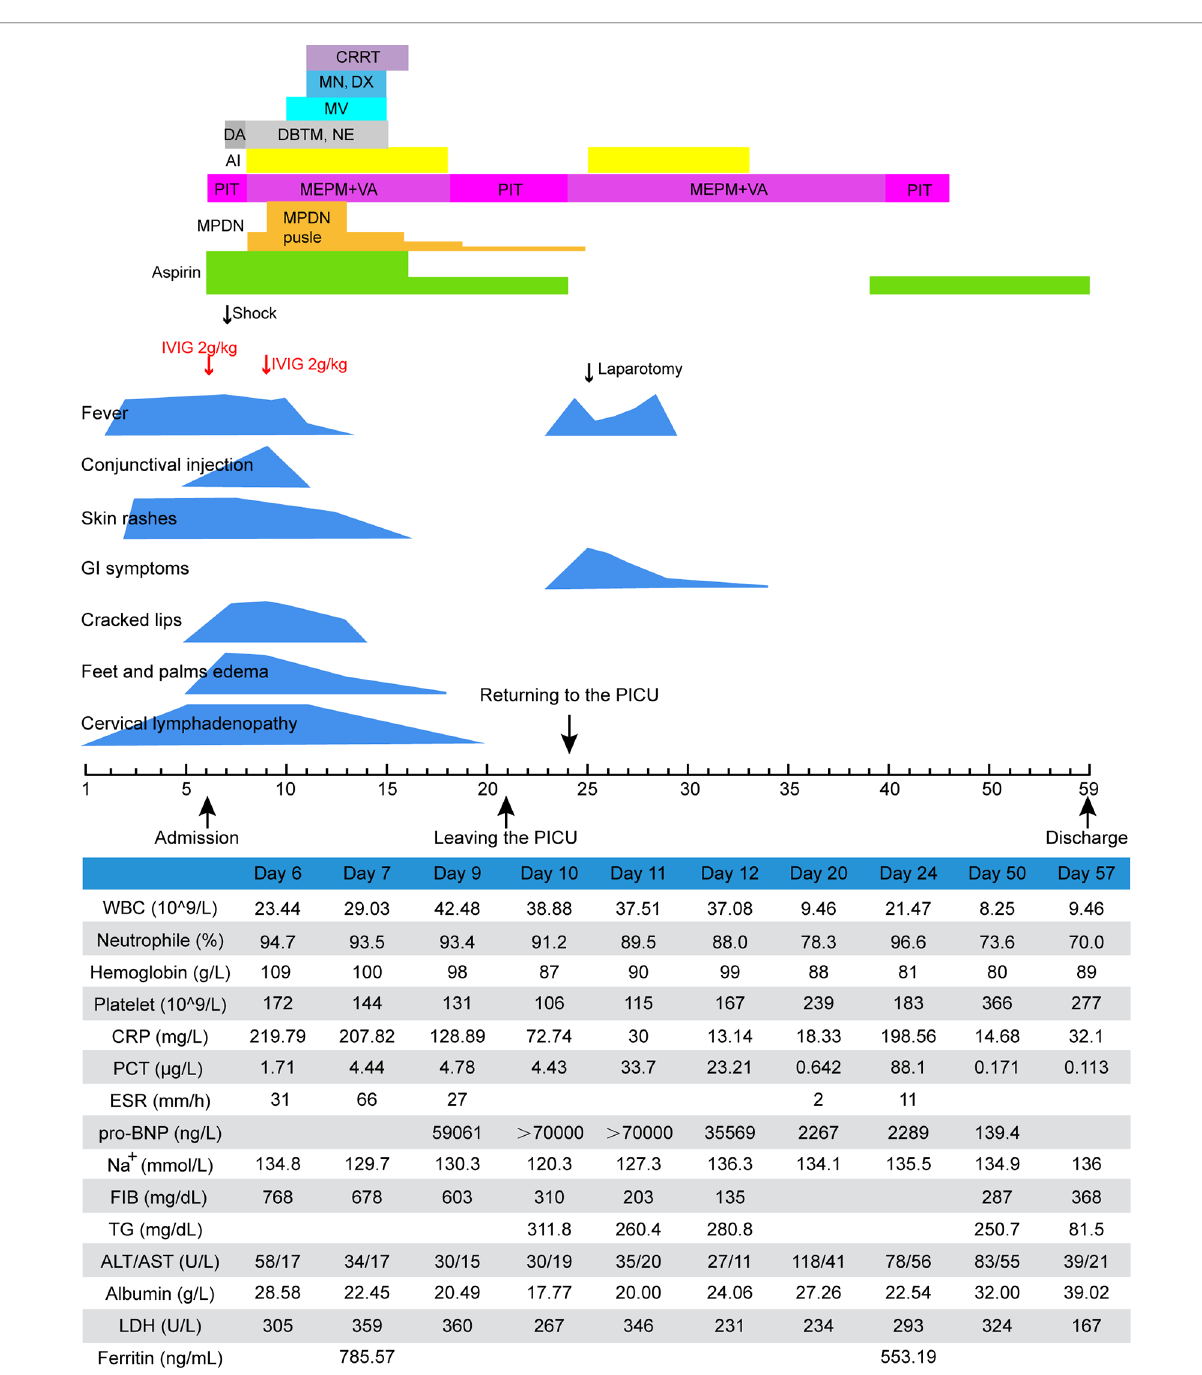
FIGURE 2 Clinical course of case 2. AI, albumin infusion; ALT, alanine transaminase; AST, aspartate aminotransferase; CRP, C-reactive protein; CRRT, continuous renal replacement therapy; DA, dopamine; DBTM, dobutamine; DX, digoxin; ESR, erythrocyte sedimentation rate; FIB, fi brinogen; IVIG, intravenous immunoglobulin; LDH, lactate dehydrogenase; MEPM, meropenem; MN, milrinone; MPDN, methylprednisolone; MV, mechanical ventilation; NE, norepinephrine; PCT, procalcitonin; PIT, piperacillin-tazobactam; pro-BNP, pro-brain natriuretic peptide; TG, triglycerides; VA, vancomycin; WBC, white blood